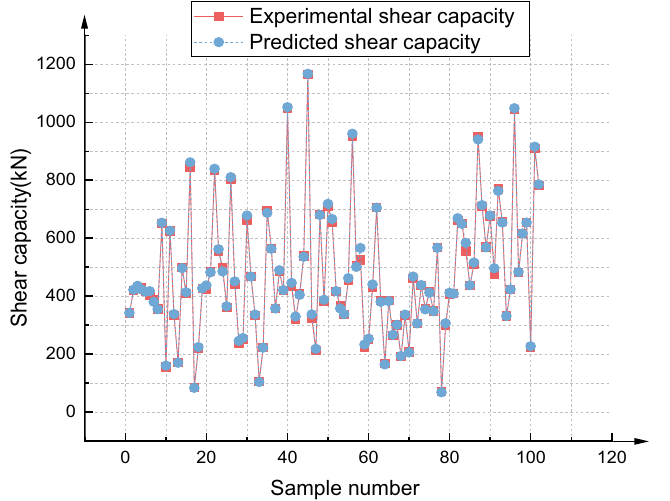
Figure 20. GA-BPNN fitting effect.